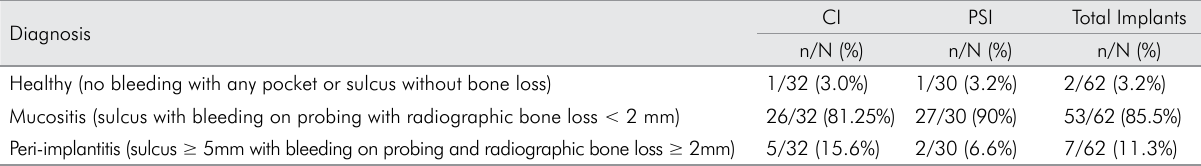
Table 5. Prevalence of mucositis and peri-implantitis according to clinical and radiographic parameters with a 5 mm cutoff and bone loss ≥ 2